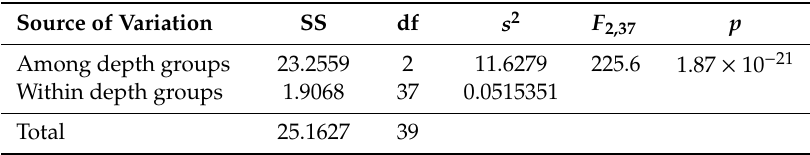
Table 4. Results of one-way analysis of variance on PCA first axis scores among the three depth groups recognized in the case of the “simulated” dataset.